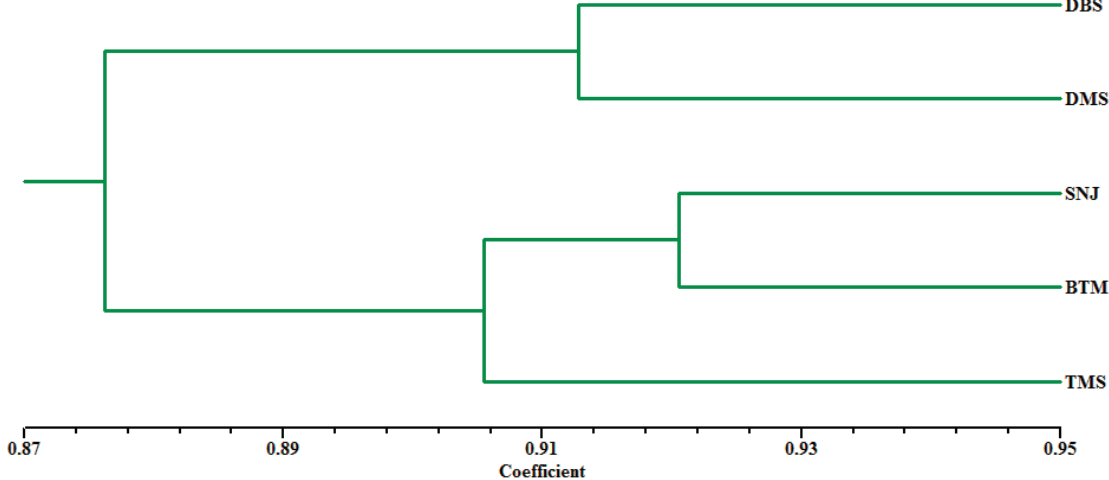
Figure 2. Arithmetic average (UPGMA) dendrogram based on Nei’s genetic distances among